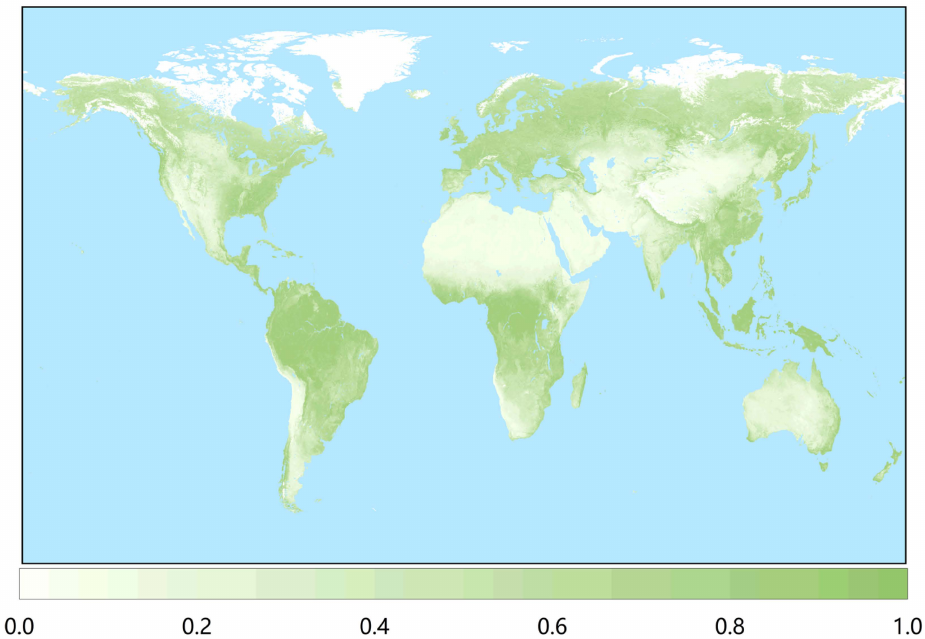
Figure 3. Global Normalized Vegetation Index (NDVI) (May 2021). The closer the color is to 1.0, the larger the area covered by green vegetation; if the color is closer to 0, this means that the area has little or no vegetation cover.